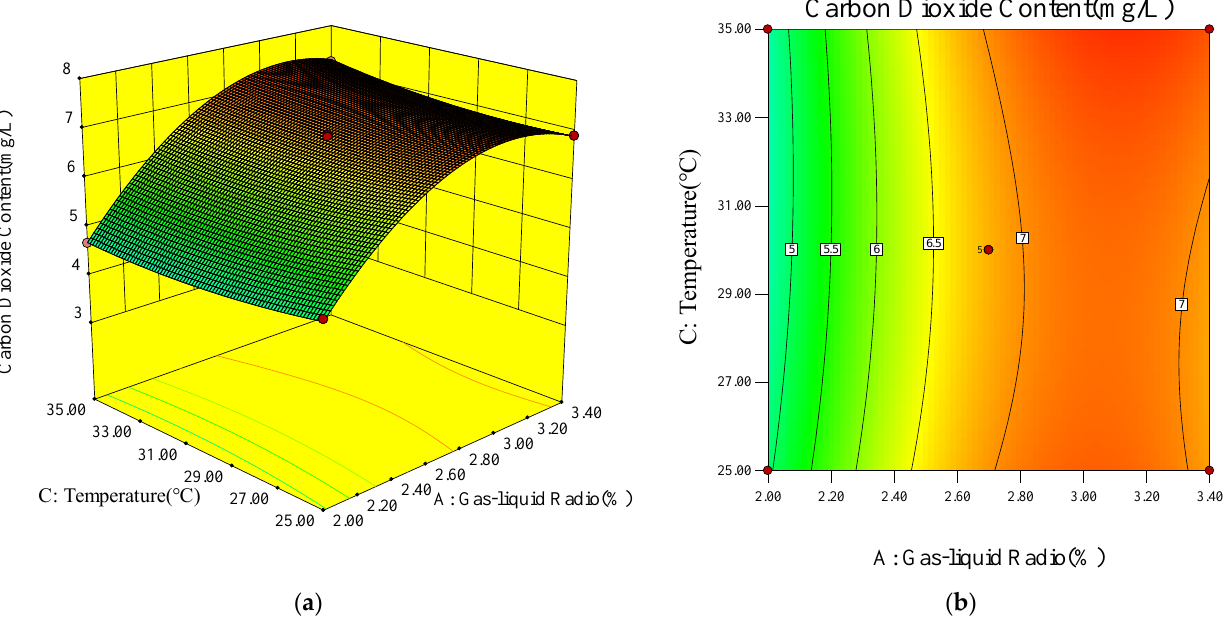
Figure 7. The interaction between the gas – liquid ratio and the inlet water temperature: ( a ) response surface and ( b ) contour lines.